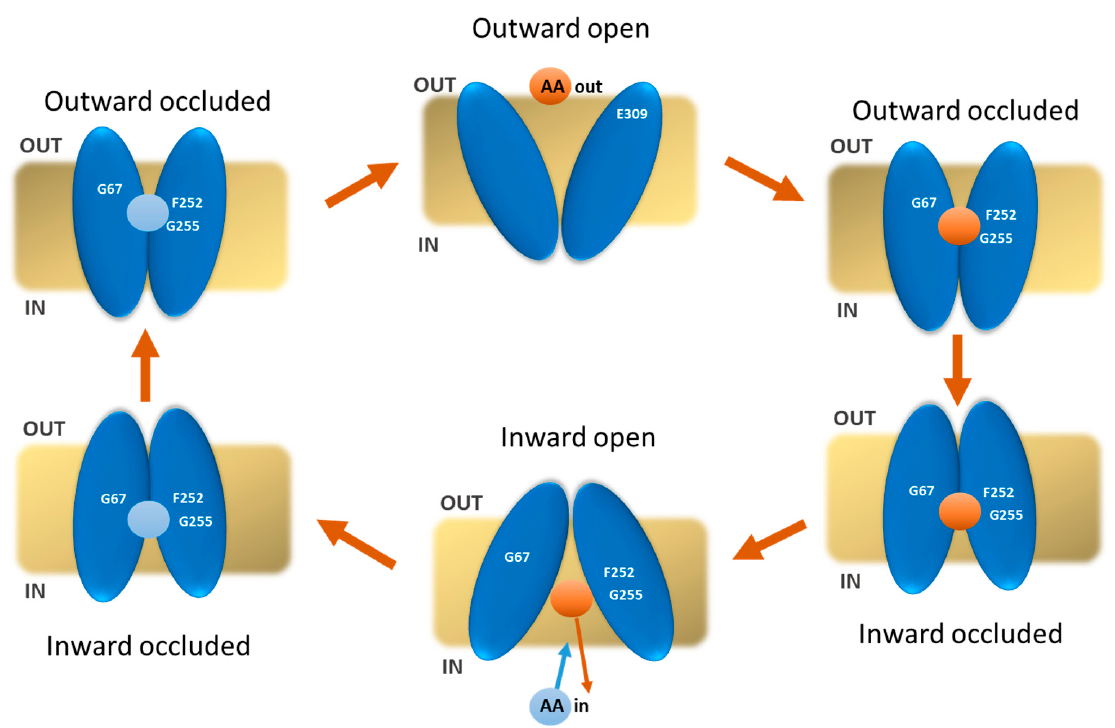
Figure 7. A sketch of the possible His transport cycle of LAT1. In the first step, the transporter is in the outward-open conformation, and the ligand can interact with the highlighted residues; the substrate is bound, and there are conformational changes carrying to the outward-occluded state; the transporter is in the inward-occluded state and in the inward open, ready to release the substrate into the intracellular side. After binding with the substrate, LAT1 returns inward occluded and finally in an outward-occluded state with the release of the substrate in the extracellular side.